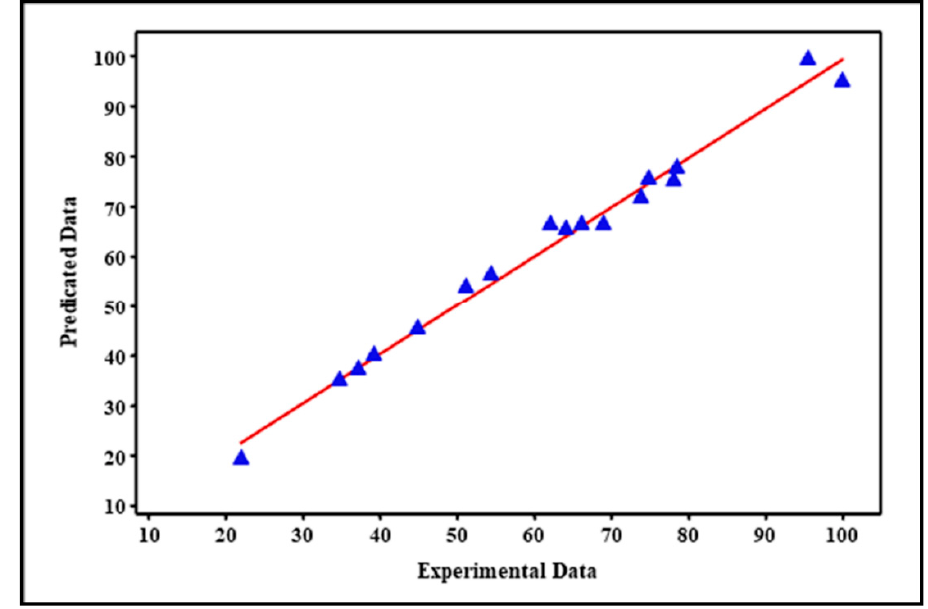
Figure 7. The predicted values of the model versus experimental values of DB15 degradation.